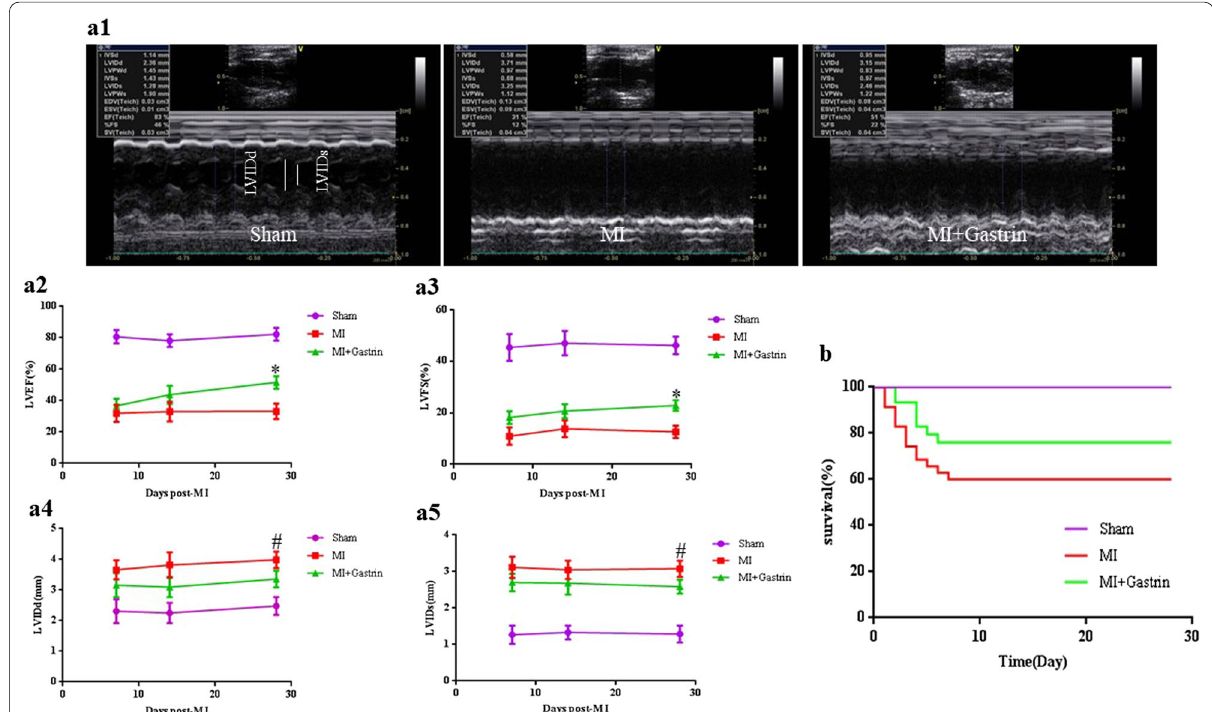
Fig. 2 Gastrin ameliorates cardiac function and survival rate in myocardial infarction mice. a1 Representative M-mode images of hearts with the sham operation or myocardial infarction 28 days after the saline vehicle and gastrin infusion. a2–5 Represent left ventricle ejection fraction (EF), fractional shortening (FS), diastolic left ventricle internal diameter (LVIDd) and systolic left ventricle internal diameter (LVIDs) after MI. n * P < 0.05, vs. MI mice; # P < 0.05, vs. MI Gastrin. b Gastrin improves Kaplan–Meier survival rate of mice subjected to MI. n +